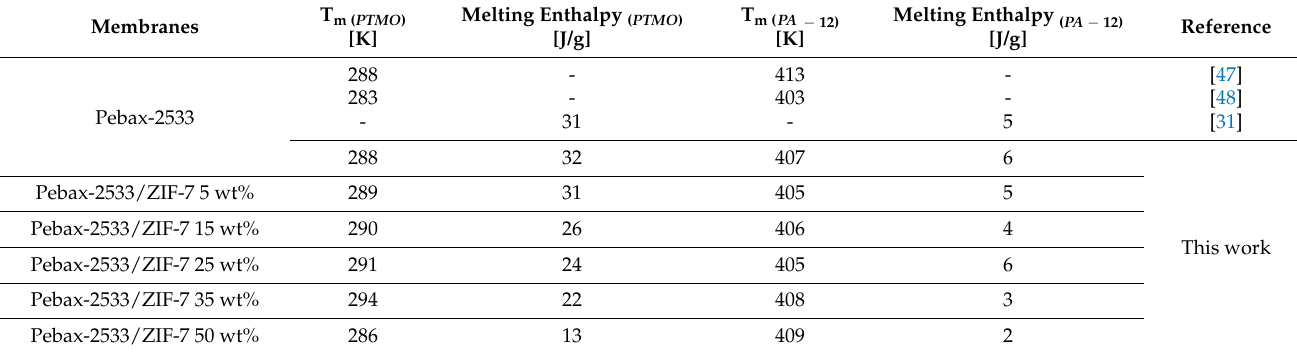
Table 3. Crystallinity of Pebax-2533/ZIF-7 composite membranes.